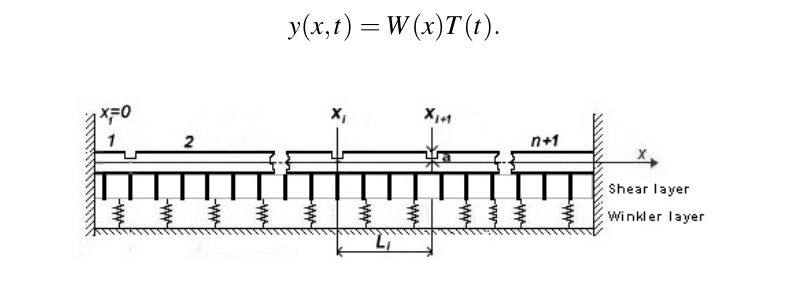
Fig. 1. A clamped beam on the Pasternak